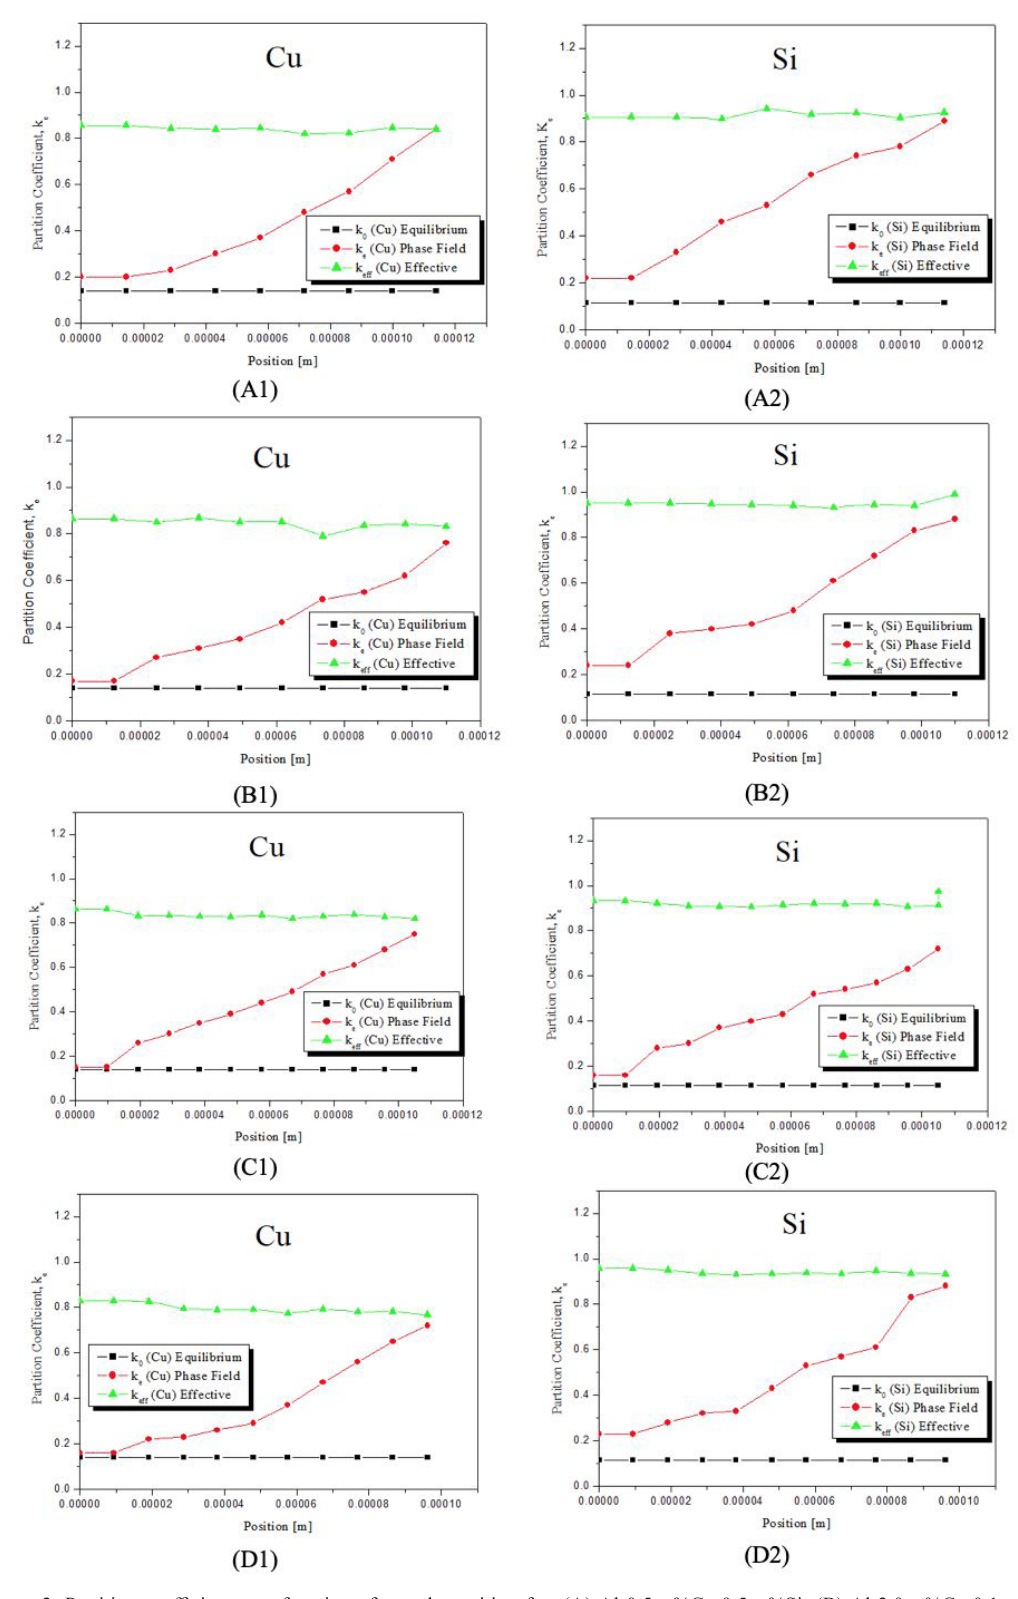
Figure 3. Partition coefficient as a function of sample position for: (A) Al-0.5wt%Cu-0.5wt%Si, (B) Al-2.0wt%Cu-0.1wt%Si, (C) Al-2.0wt%Cu-1.0wt%Si, (D) Al-4.0wt%Cu-0.1wt%Si